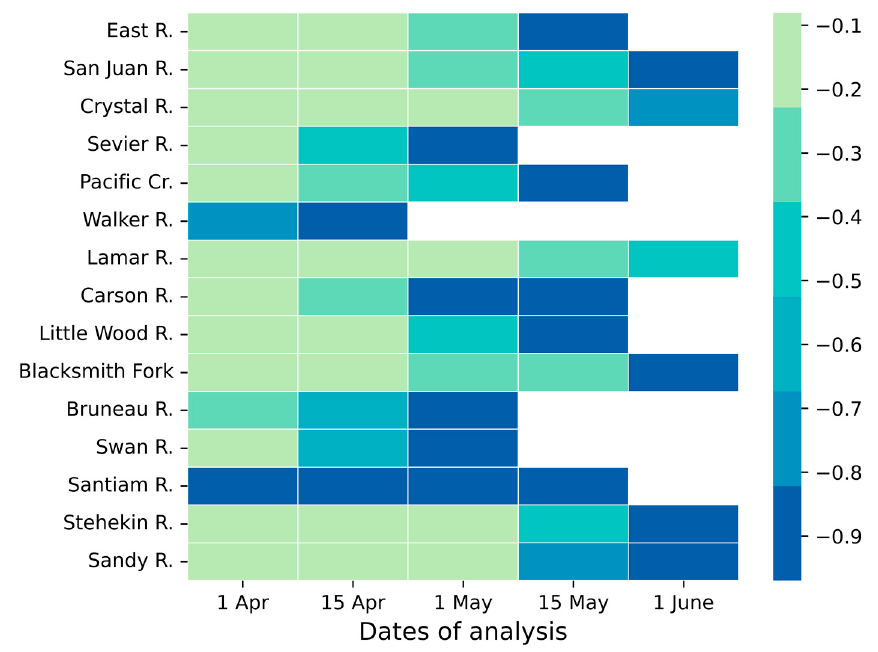
Figure 7. The differences between the QCD for DSD mean and SNOTEL SWE data through time. Negative values indicate that the spread of data relative to its first and third quartile is higher for SNOTEL SWE. Blank values indicate that the Q1 value is equal to zero, or there is no remaining SWE measured at the basin’s SNOTEL site by this date in at least 25% of the study years.